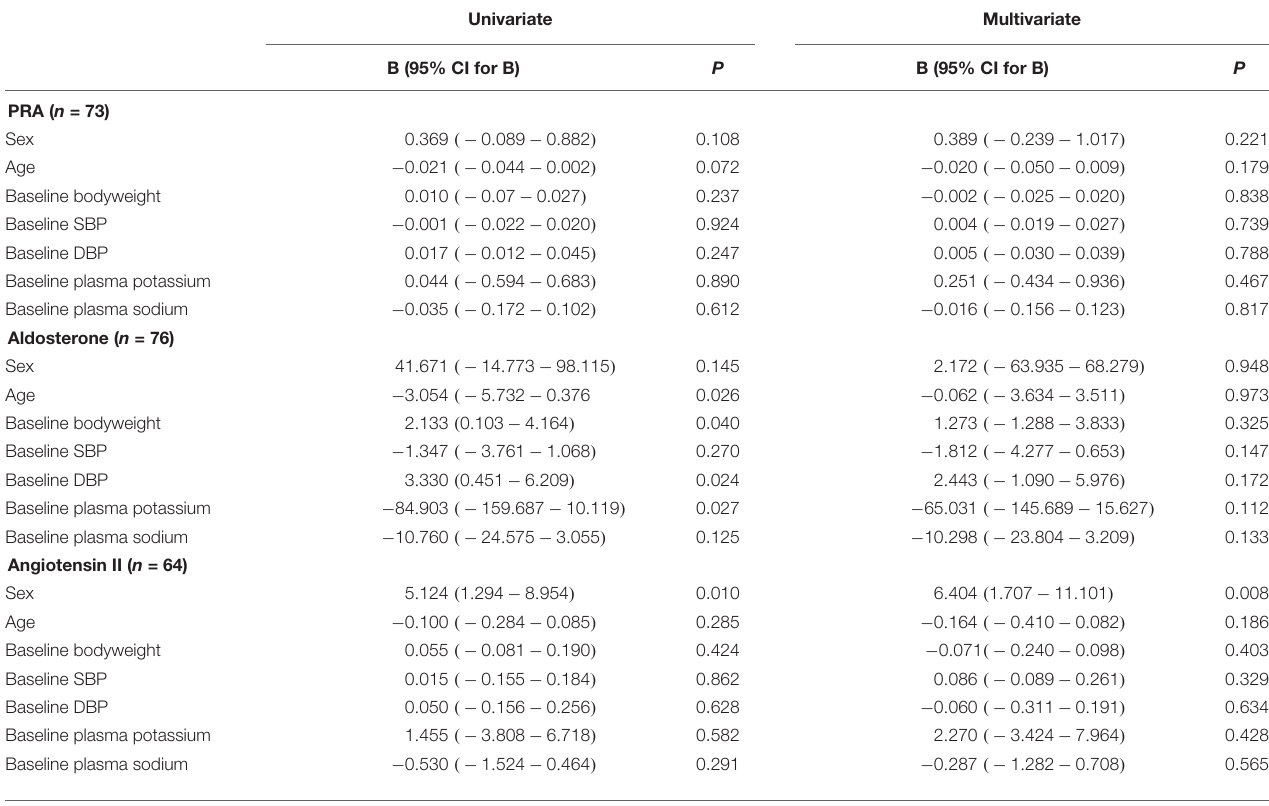
TABLE 2 | Linear regression analysis for the factors that may influence plasma renin activity (PRA), aldosterone and angiotensin II concentrations. Univariate